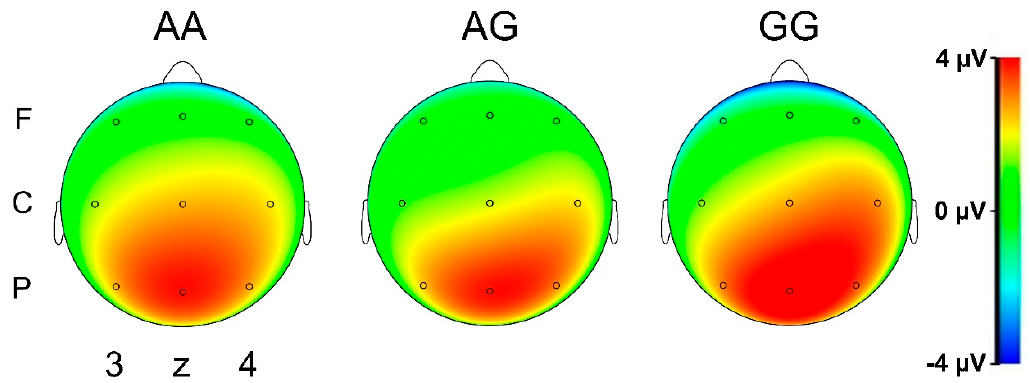
Figure 3. Rightward P300 shift in healthy rs2199430 G allele carriers during CPT target trials. EEG heatmaps for P300 amplitudes in healthy controls with different rs214430 genotypes during target trials of the 2-back condition of the CPT. Maps depict the field distribution of the P300 at the peak of the global field power. G allele carriers exhibit a significant shift of P300 amplitudes to the right compared to individuals with the homozygous AA genotype. F: frontal, C: central, P: parietal, 3: left, z: midline, 4: right.